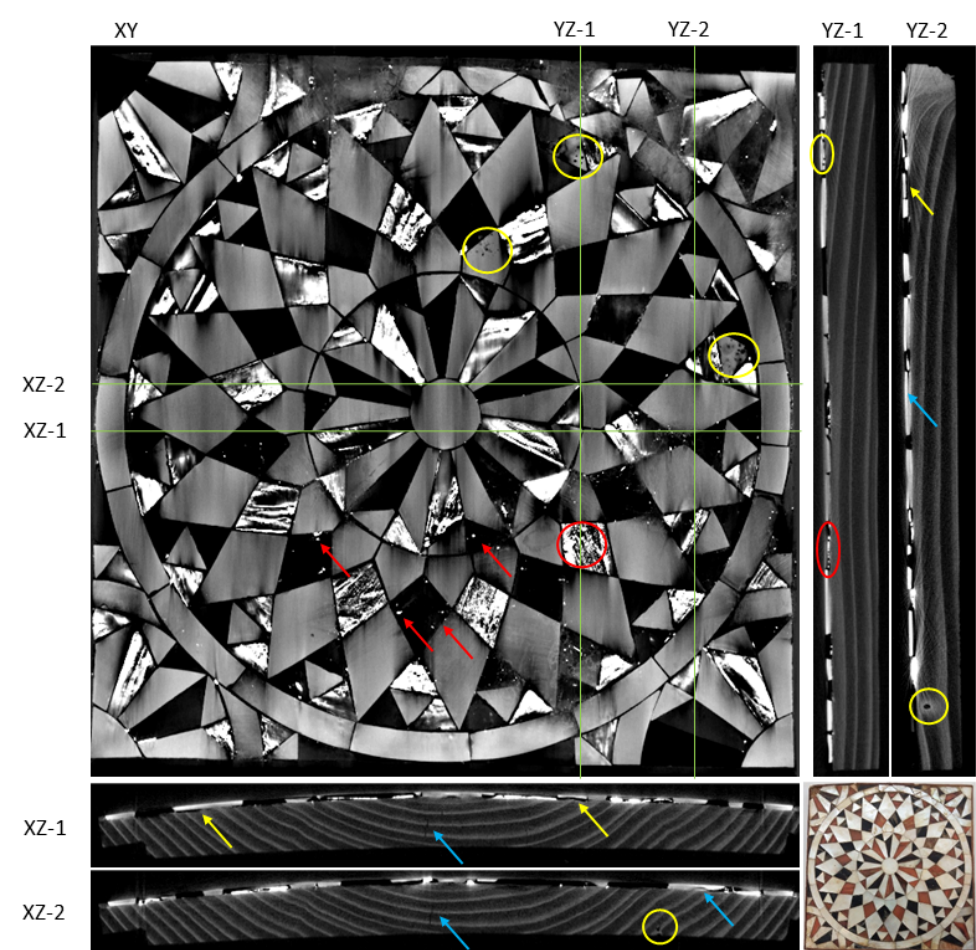
Figure 6. 2D slices of the reconstructed volume showing pores (yellow circle), cracks (blue arrow), delamination (yellow circle), and inclusions (red arrows). Due to the curvature of the sample, the XY-plane is a non-planar cross section through the sample surface and can be compared to the picture of the marquetry in the bottom right hand